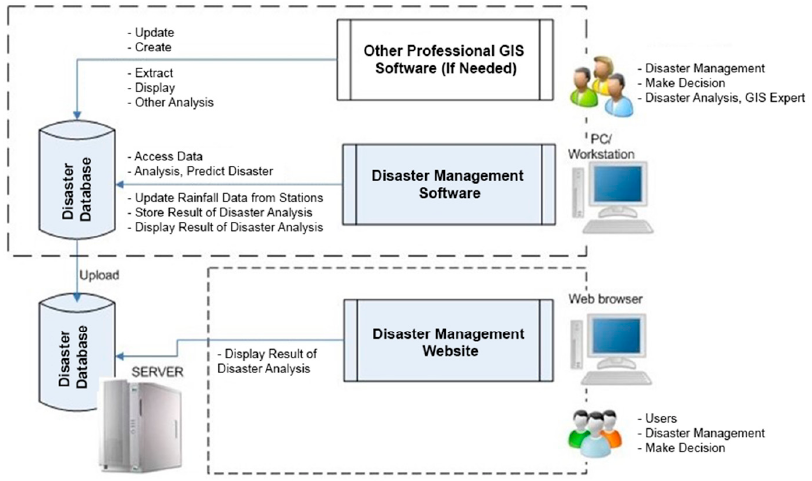
Figure 8. Generalized model and key features of flash flood warning software.